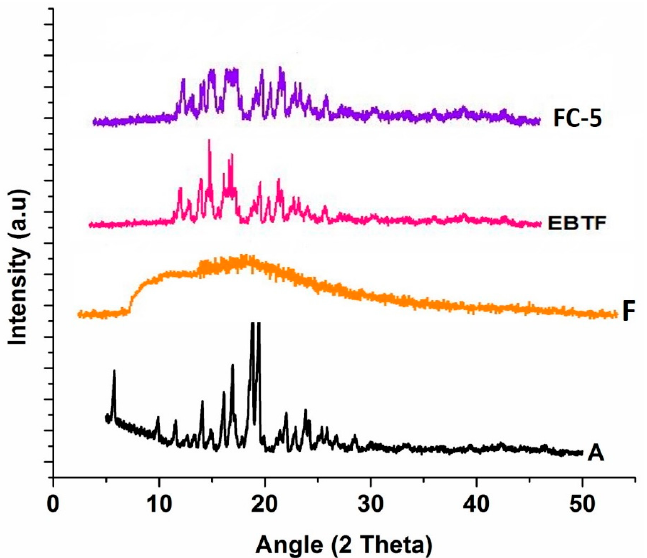
Figure 5. XRD diffractograms (A) EBT drug, (F) blank film, (EBTF) EBT plain film, (FC-5) micelles- loaded film.